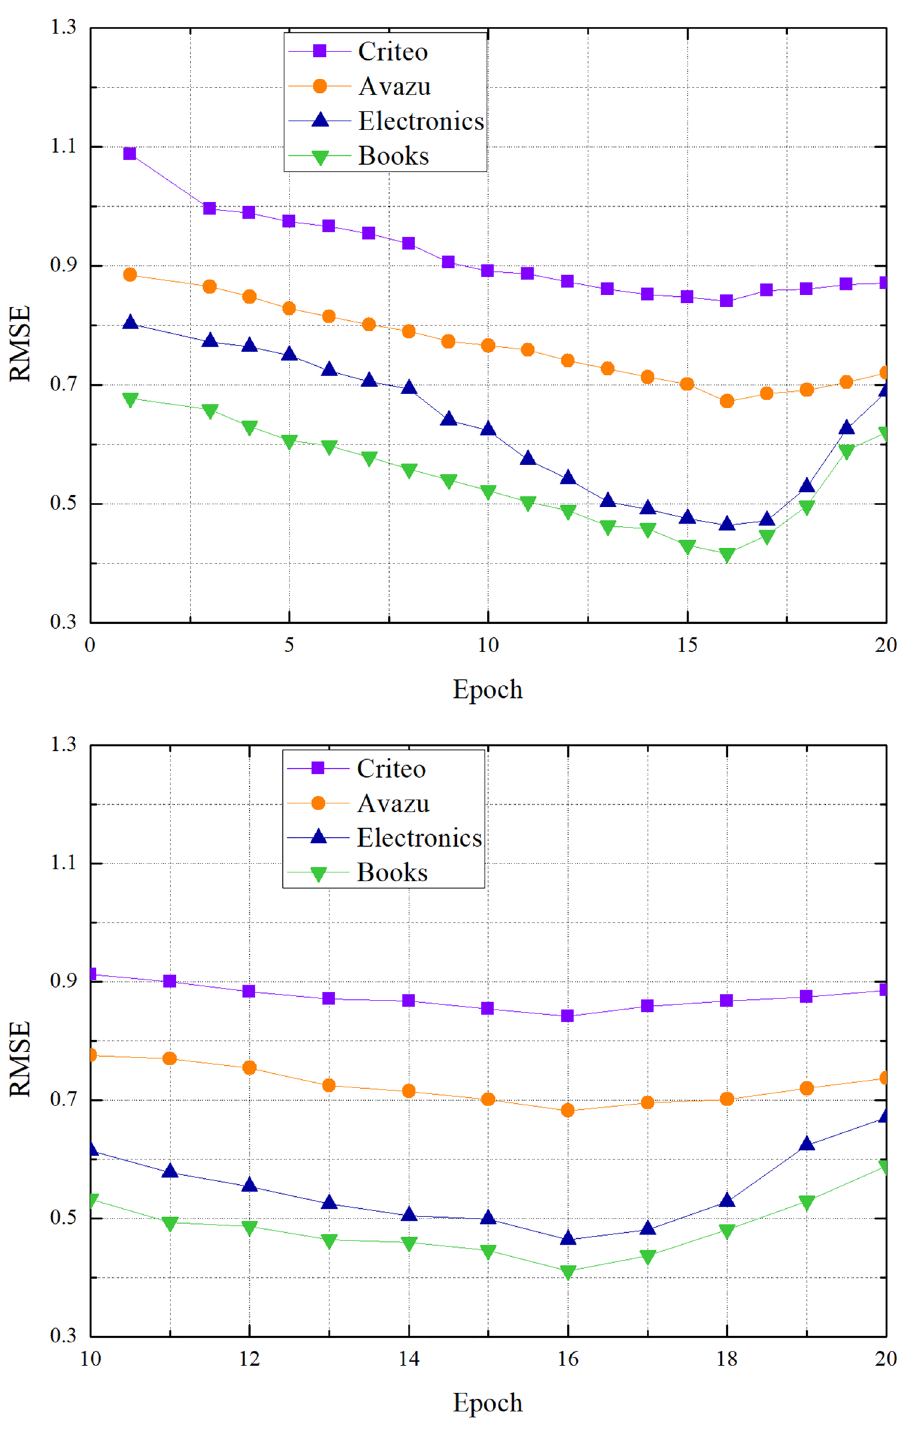
Figure 6. The effect of the